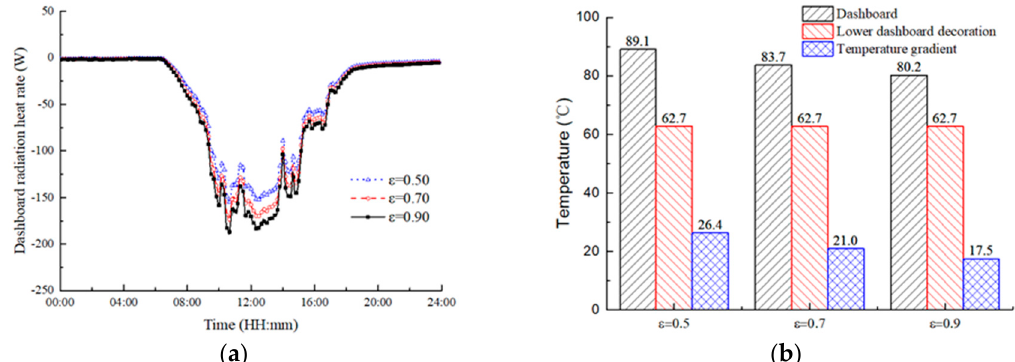
Figure 13. Influence of emissivity on regulation of heat transfer and temperature gradient: ( a ) radiant heat dissipation of dashboard; and ( b ) maximum temperature and temperature gradient.